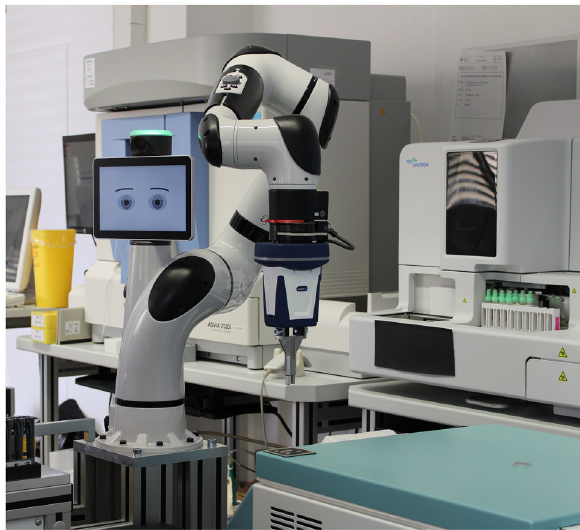
Figure 1: Installation of the Sawyer in the medical lab.